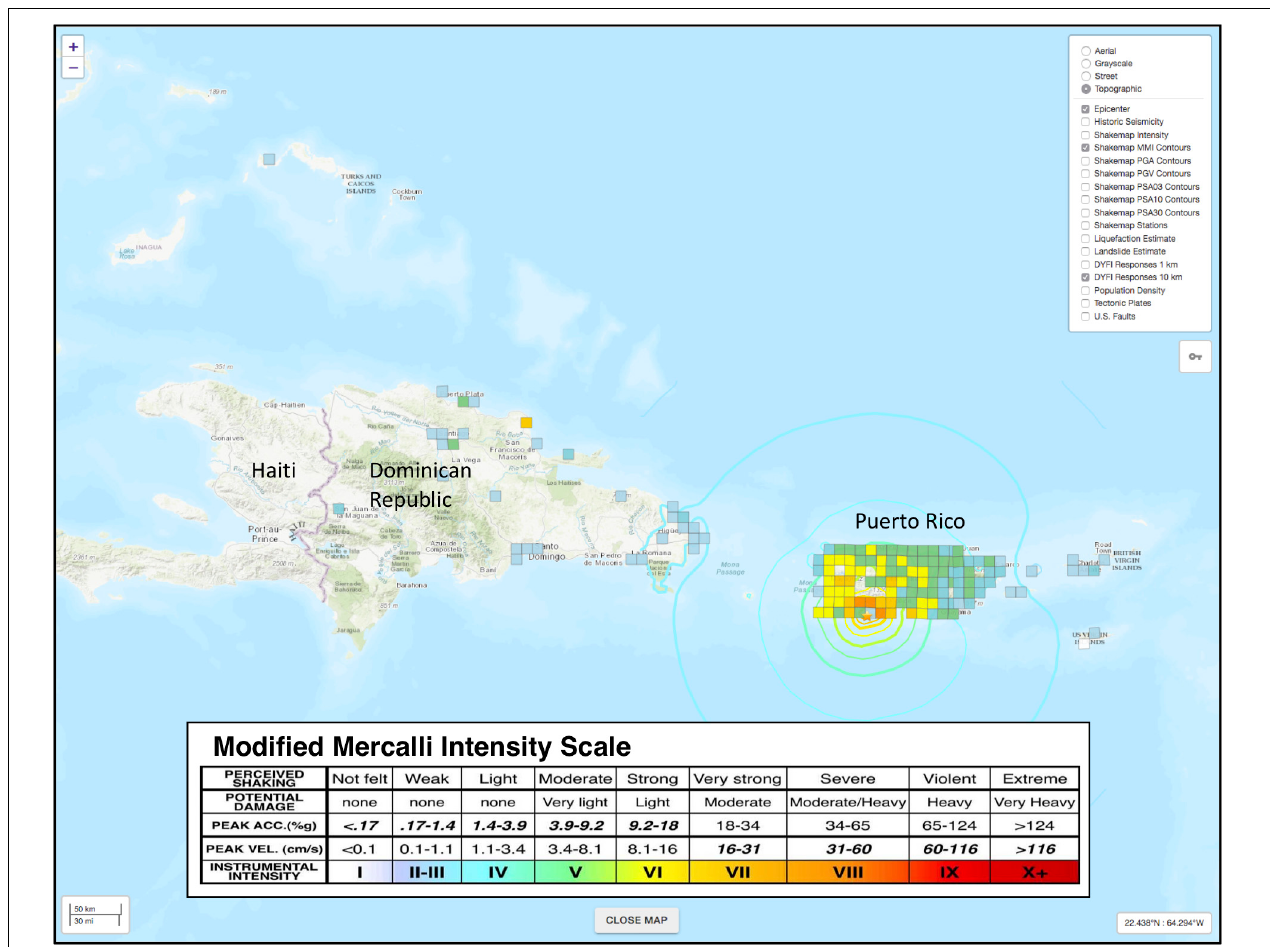
FIGURE 1 | Interactive map from the USGS event web pages for the M6.4 Indios, Puerto Rico earthquake at a regional scale displayed in 10-km square blocks color-coded to the inset legend used by DYFI and ShakeMap to show the intensity (Wald et al., 2011). ShakeMap isoseismal contours are shown using the same color scheme (Source: U.S. Geological